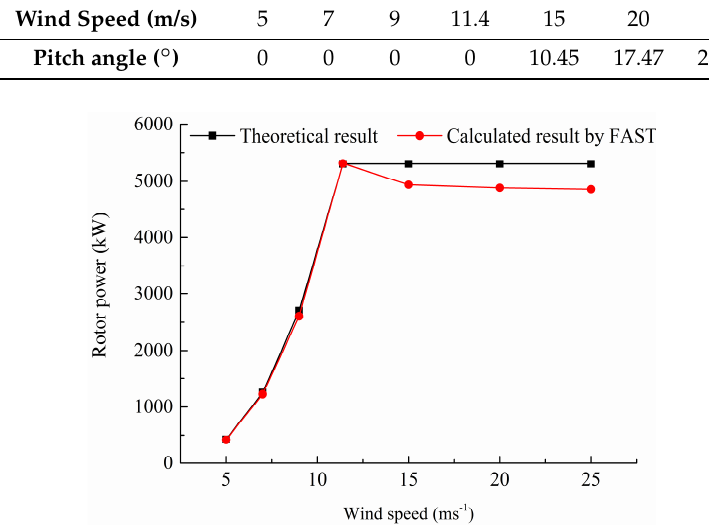
Figure 5. Rotor power at different wind speeds. FAST: fatigue, aerodynamics, structures, and turbulence.